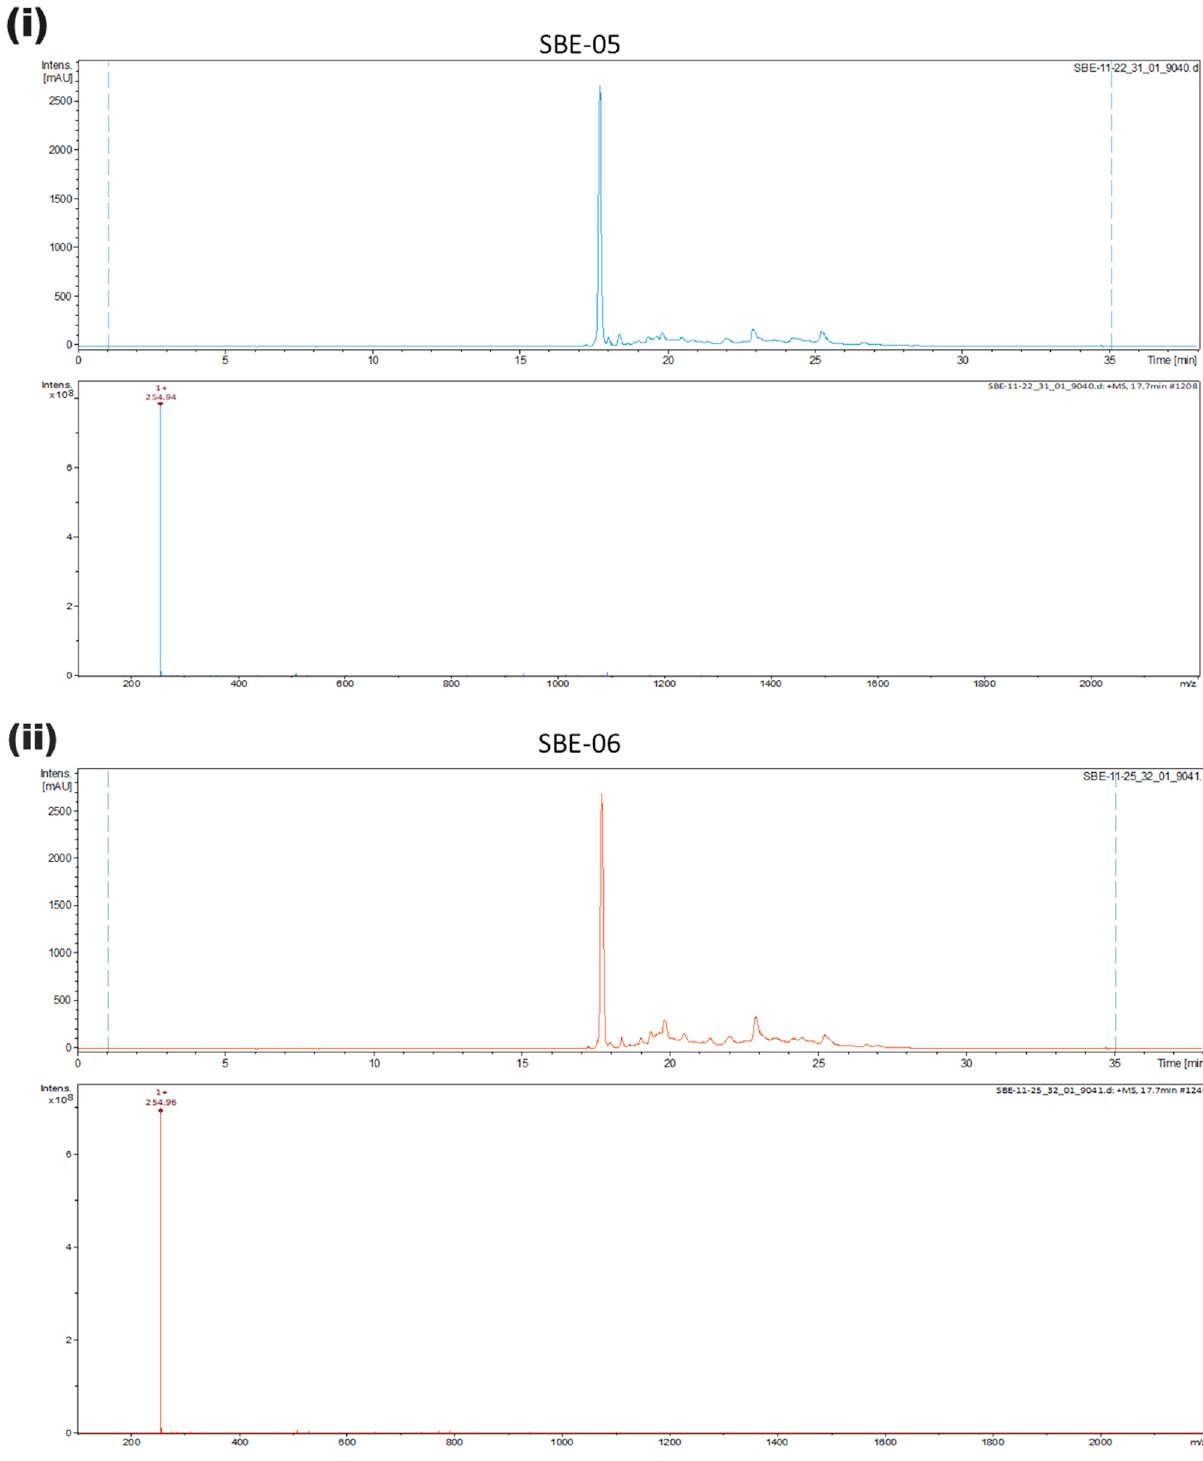
Figure 2. (i–iii). LC–MS analysis revealed enrichment of a compound with a molecular weight of 255 in SBE- 05, SBE-06 and SBE-07 . SBE: SBE: Sorghum bicolor